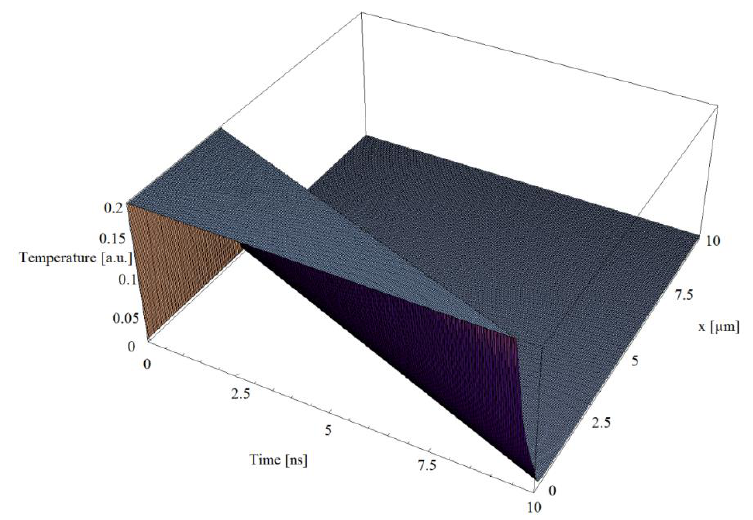
Figure 6. Spatial-temporal distribution of electron temperature density evolution in the case of one laser pulse of 100 fs application onto an Au surface for τ = 0.5 ps relaxation time (10 ns).